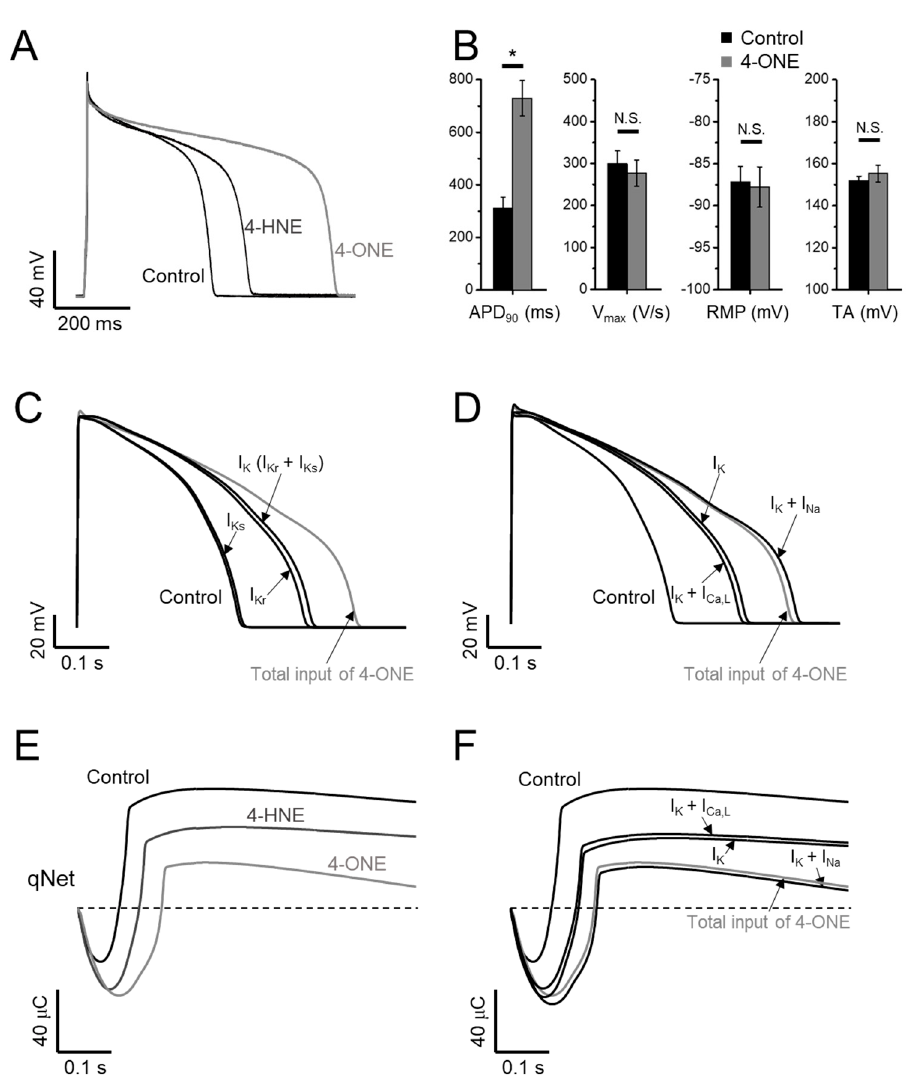
Figure 5. Effects of 4-ONE and 4-HNE on guinea-pig action potential (AP) and in silico AP. ( A , B ) Representative traces of AP show prolonged AP duration (APD) by 4-HNE (100 μ M) and 4-ONE (10 μ M) in GPVMs. ( B ) The APs were analyzed by APD at 90% repolarization (APD 90 ), maximum overshoot velocity of AP (V max ), resting membrane potential (RMP), and total amplitude (TA). ( C – F ) A CiPAORdv1.0 cell model was used for 4-ONE and 4-HNE simulation. ( C ) The contribution of APD prolongation simulated by I K (I Kr and I Ks ) input by 4-ONE. ( D ) The contribution of APD prolongation simulated by I Ca,L and I Na (I NaV and I NaL ) added to I K input. ( E ) qNet (net charge carried by total ionic currents) was calculated under 4-HNE and 4-ONE inputs. ( F ) The contribution of qNet simulated by I Ca,L and I Na added to I K input. All the data were analyzed using paired t-tests, where a p < 0.05 was considered statistically significant ( ∗ ).